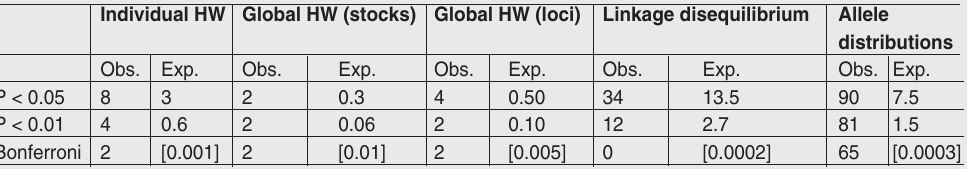
Table 3. Tests of Hardy-Weinberg Equilibrium, linkage disequilibrium, and allelic distribution across the six walrus stocks. Three significance levels are shown, with the expected number of Type I error if the null hypothesis is correct given each alpha value. Square brackets denote the Bonferroni-corrected alpha value. (Obs. = Observed, Exp. = Expected)